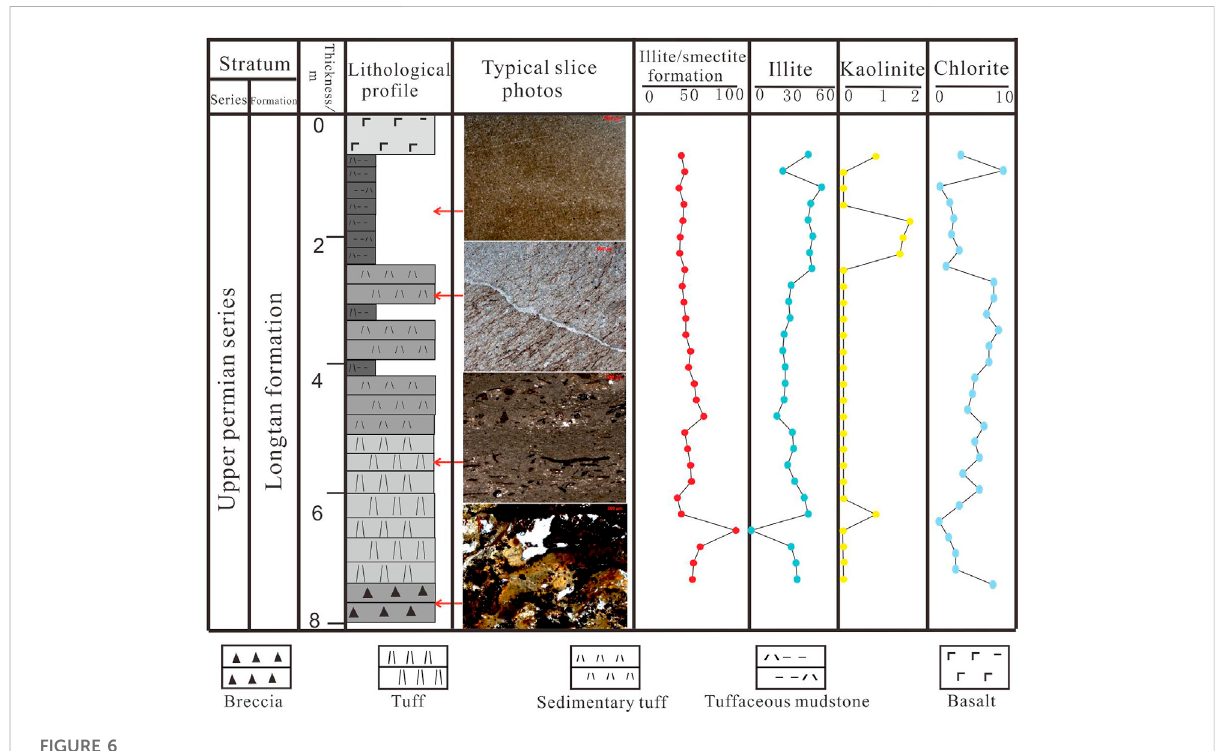
FIGURE 6 XRD Data of Clay for Tuffaceous Section of Hongyan Township pro fi le.